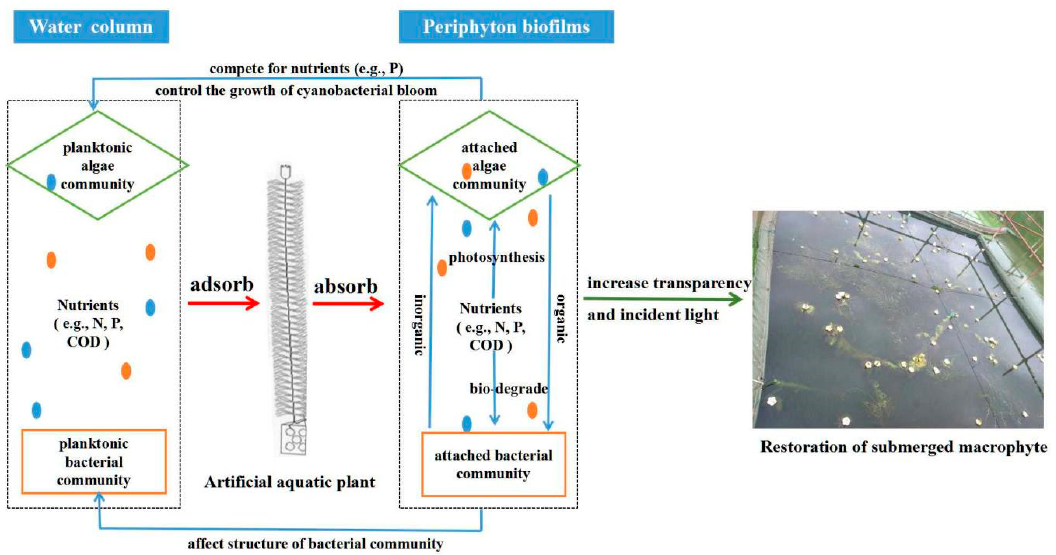
Figure 8. Mechanism of bioremediation for the restoration of submerged macrophytes.